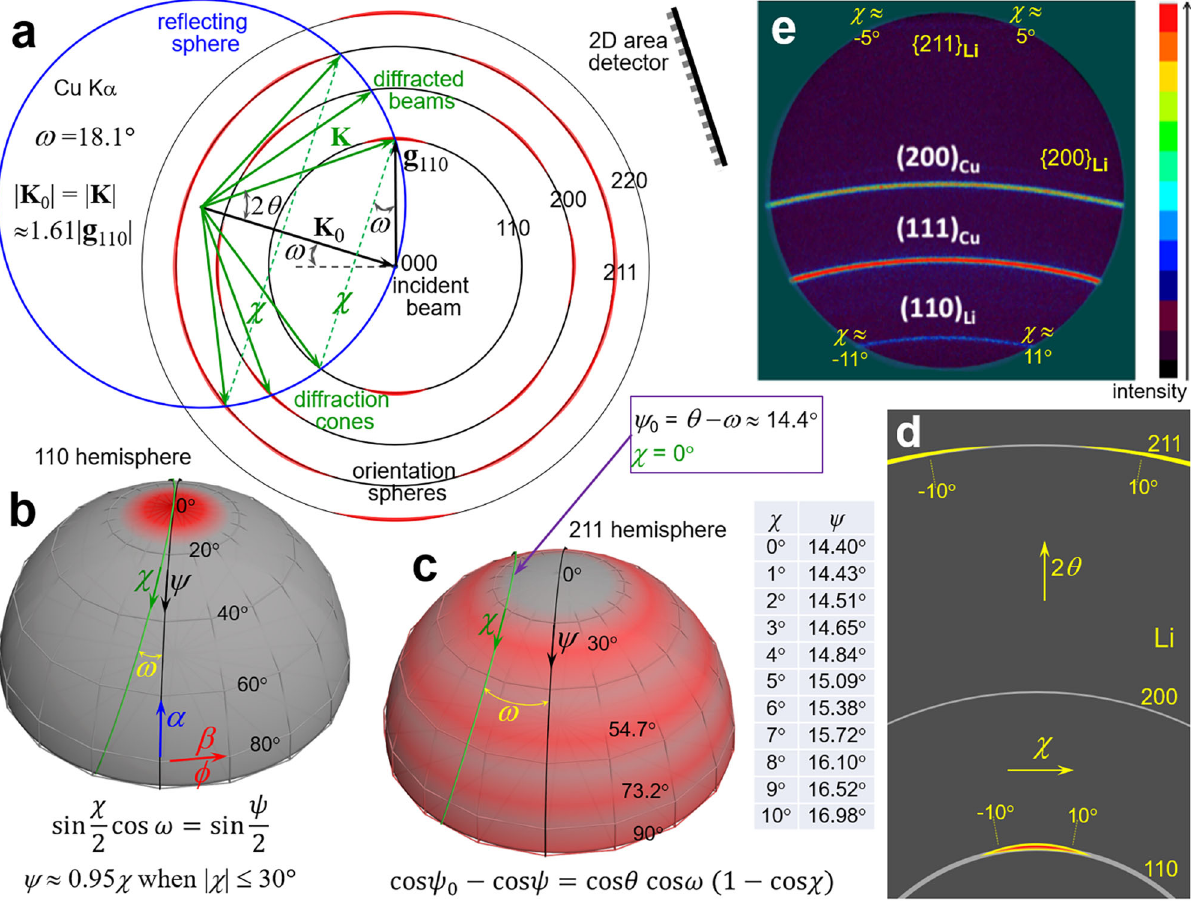
Fig. 1 | XRD analyses of crystallographic orientation distribution in deposited lithium on isotropic polycrystalline Cu. a – d Schematic drawings in reciprocal space to show the geometry requirement producing diffraction with intensity variation from polycrystal Li, which is a mixture of randomly oriented grains and (110)-texturedgrainswiththetiltspread Δ ψ of ≤ 15°. a Superimposingthereciprocal lattice of a dominantly (110)-textured polycrystal Li on the re fl ecting sphere con- struction demonstrates the geometric conditions producing Debye diffraction cones of intensity variation. A set of homocentric spherical surfaces display raised red spherical crowns or broad latitude-zones denoting enhanced orientation den- sityduetothescattered(110)texture.Theyintersectwiththere fl ectingsphereata set of coaxial circles χ representing the allowed Bragg re fl ections. The incident angle ω ≈ 18.1° was told by the fi rst author Zhao. b {110} orientation hemisphere showing thetiltscatterof (110) fi ber textureand the relationbetween the tiltangle ψ and the diffraction azimuth χ . The gray denotes well-distributed random orien- tation of low pole density while the red arctic area the scattered texture of